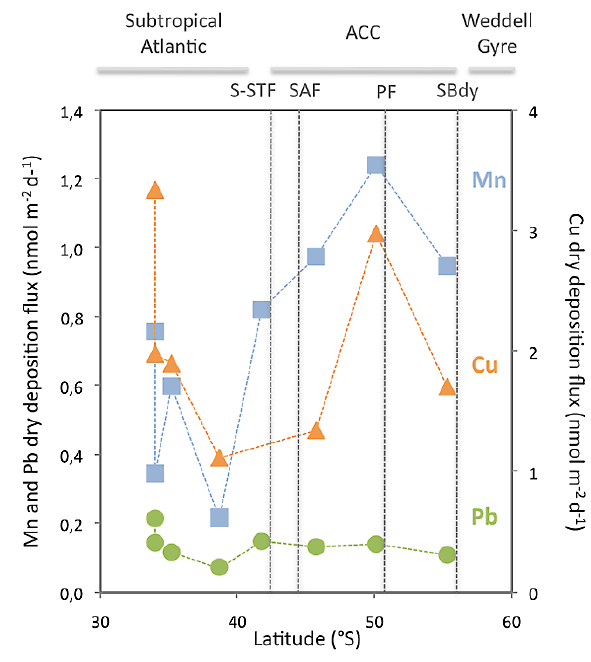
Fig. 6. Dry deposition flux of Mn (blue squares), Cu (orange tri- angles) and Pb (green circles) (in nmolm − 2 d − 1 ) as a function of latitude along the section in the southeastern subtropical Atlantic and the Southern Ocean. An estimated dry deposition velocity of 0.3cms − 1 was used to calculate the fluxes. Ag and Cd dry deposition fluxes were extremely low along the sec- tion: from < 0.06nmolm − 2 d − 1 in the northernmost part of the section to < 0.02nmolm − 2 d − 1 in the southern side of the ACC for Ag, and below 0.05nmolm − 2 d − 1 in the northernmost area to < 0.01nmolm − 2 d − 1 in the southern side of the ACC for